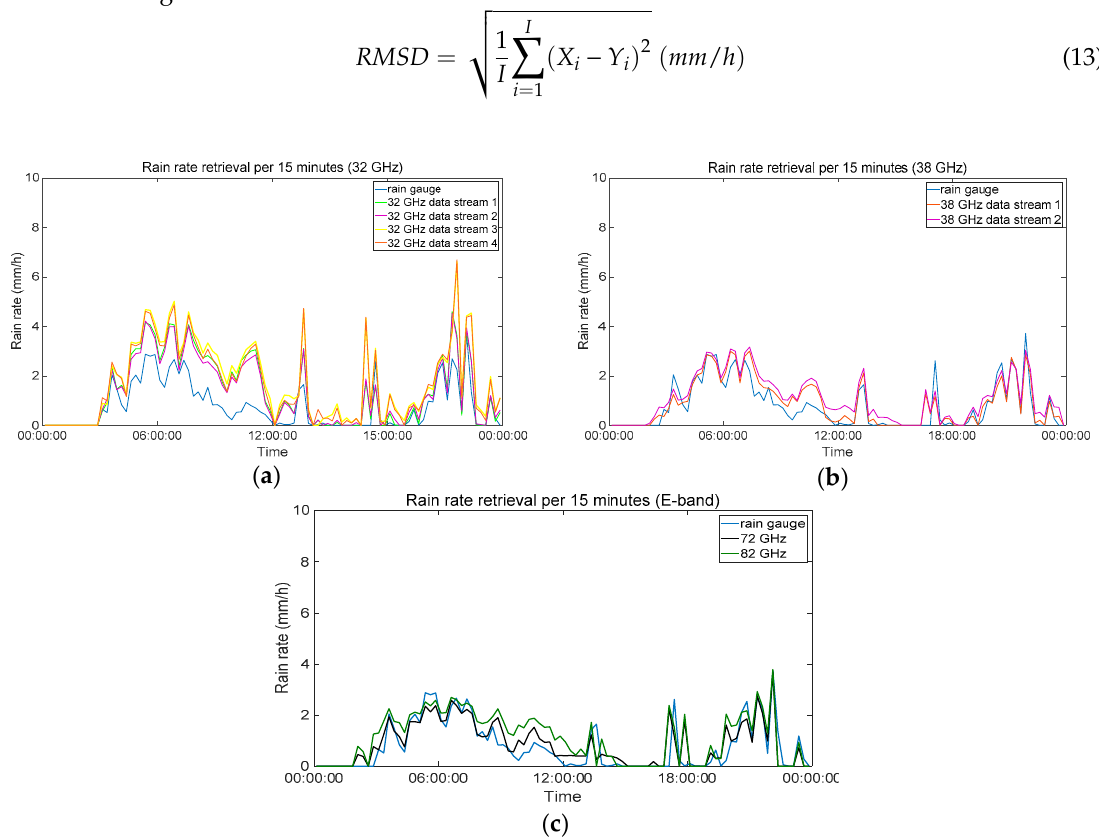
Figure 8. Average rain rate per 15 min derived from the signal link compared with the rain gauge measurement on 7 June 2017: ( a ) 32 GHz link; ( b ) 38 GHz link; ( c ) E-band link.